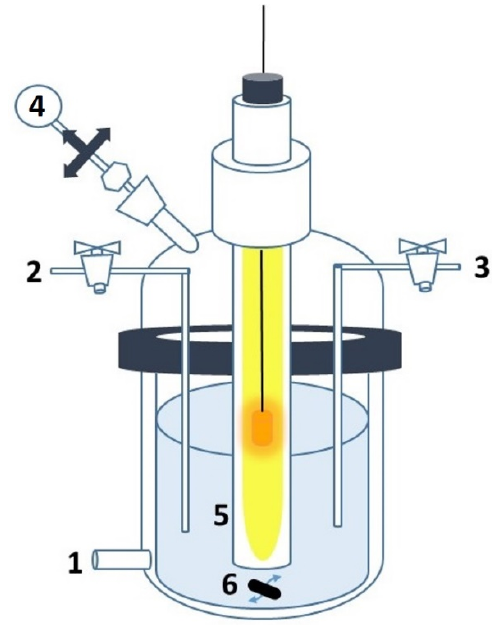
Figure 7. Sketch of the experimental photoreactor. (1) Water cooling system; (2) out gassing/gas feeding line; (3) liquid sampling; (4) gas sampling and line to gas chromatograph; (5) quartz shelter; (6) magnetic stirring.